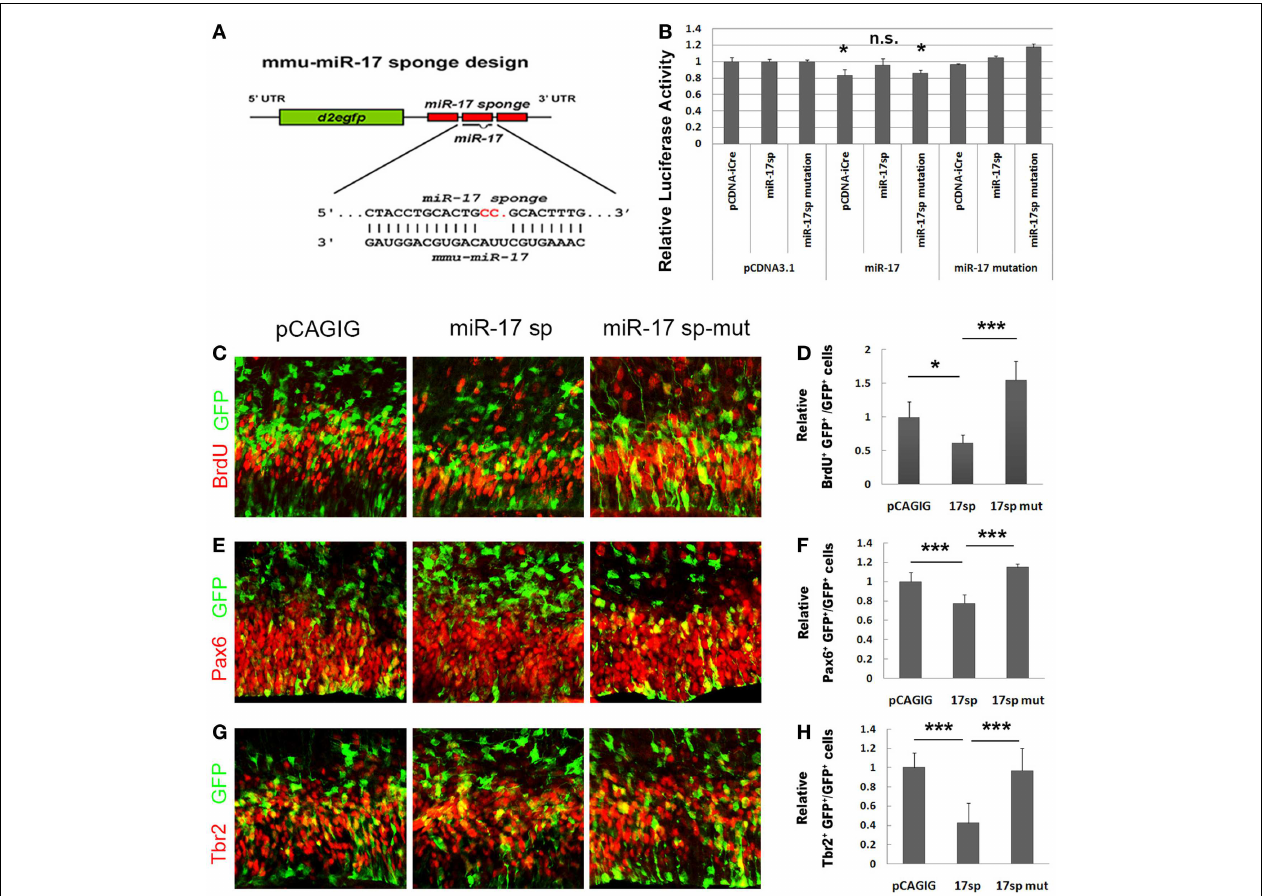
sp) in E13.5 mouse cortices ( n = 4), analyzed at E14.5, decreased the number of proliferating cells co-labeled with GFP and BrdU. A mutated miR-17 sponge (miR-17 sp-mut) ( n = 3) failed to do so. (E,F) Expression of miR-17 sponge in E13.5 mouse cortices ( n = 6) decreased the number of RGCs co-labeled with GFP and Pax6. A mutated miR-17 sponge ( n = 3) failed to do so. (G,H) Expression of miR-17 sponge in E13.5 mouse cortices ( n = 4) decreased the number of IPs co-labeled with GFP andTbr2. A mutated miR-17 sponge ( n = 4) failed to do so. Data are presented as mean ± SEM; n ≥ 3 in all constructs; p values in relation to the control (* p < 0.05, *** p <